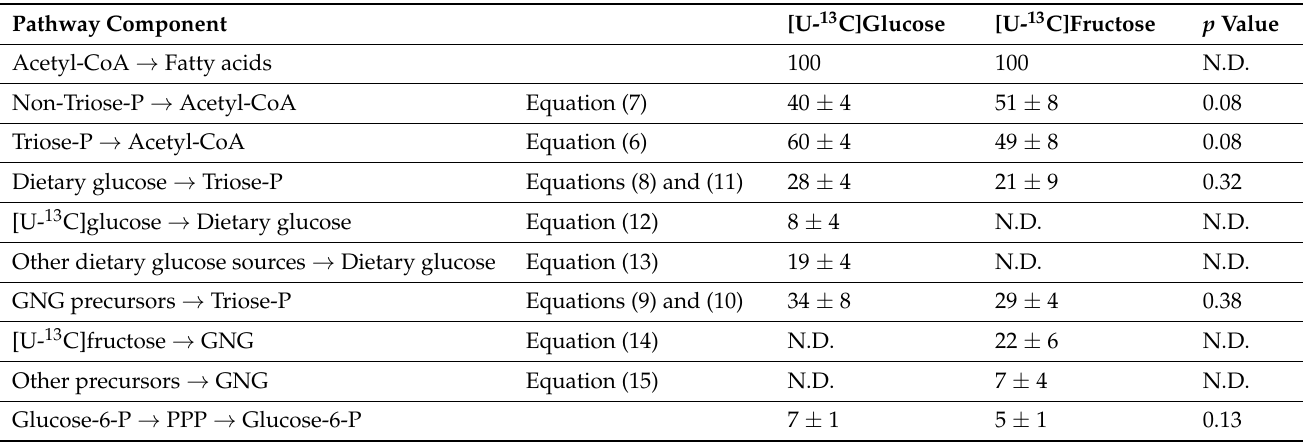
Table 2. Estimates of substrate fluxes contributing to lipogenic acetyl-CoA expressed as a fraction of total lipogenic acetyl-CoA flux into fatty acid synthase from 2 H enrichment and 13 C-isotopomer analysis of a group of mice provided with 2 H 2 O and [U- 13 C]glucose tracers (n = 4), and a group provided with 2 H 2 O and [U- 13 C]fructose (n = 5). The estimated pentose phosphate pathway (PPP) fluxes involved in glucose-6-P oxidation and carbon recycling to regenerate glucose-6-P